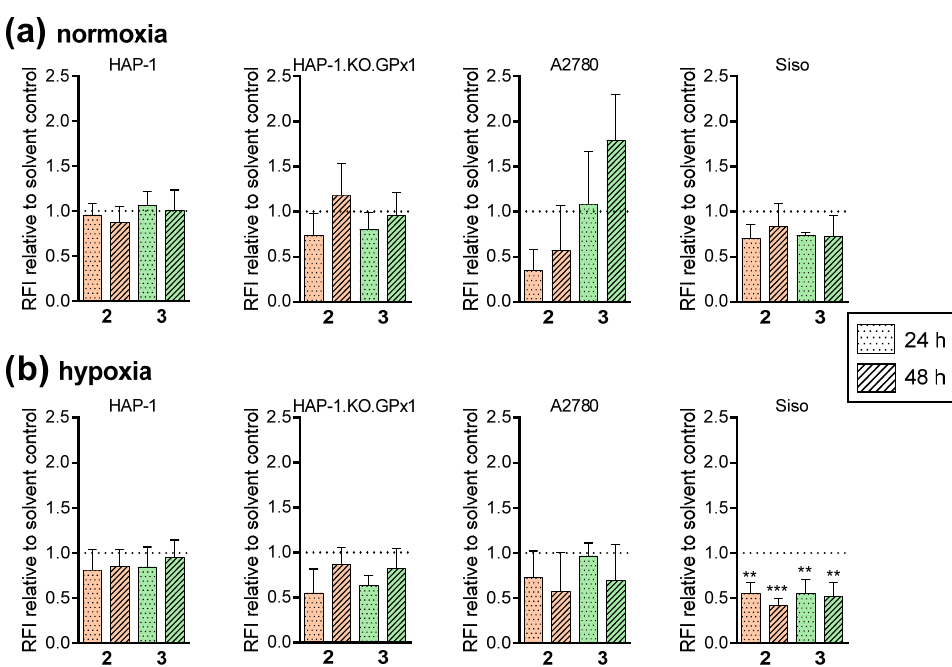
Figure 10. Relative intracellular levels of ROS after an incubation for 24 or 48 h with the respective pentathiepin 2 or 3 (IC 90 ) under normoxic ( a ) or hypoxic ( b ) conditions detected via flow cytometric DCFDA-based assay in four cell lines. All treatment conditions were related to the negative control sample (set to 1; dashed line), displayed as mean with SD and statistical analysis was performed in Prism 7 by one-way ANOVA and Dunnett’s multiple comparisons post hoc test. n ≥ 3 independent experiments, ** p < 0.01, *** p < 0.001.